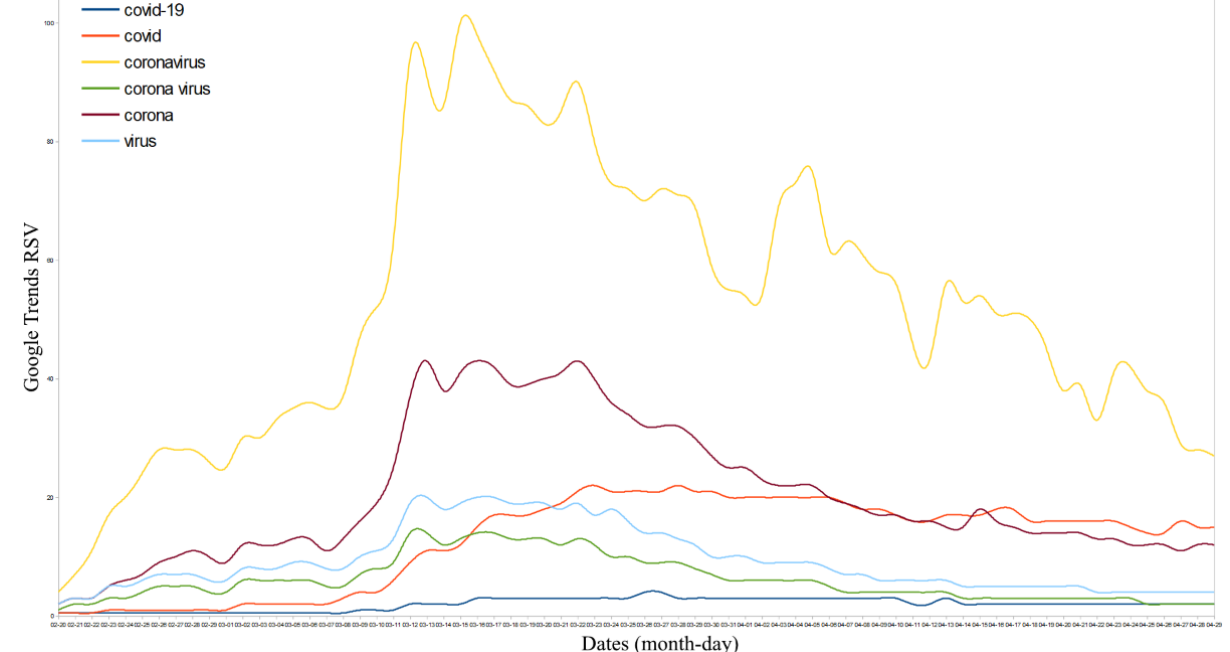
Table 1. Top infodemic and scientific Google searches related to coronavirus disease (COVID-19) globally.